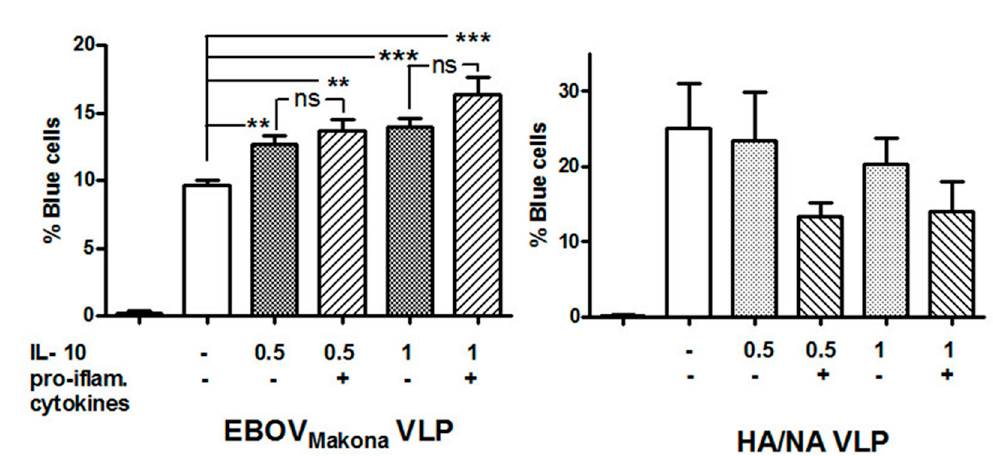
Figure 6. The enhancing e ff ect of IL-10 on EBOV VLP entry is preserved in the presence of pro-inflammatory cytokines. ( A ) MDM were pre-treated with IL-10, TNF- α or a combination of both for 48 h (IL-10 and TNF- α were used at a concentration of 20 ng / mL) and infected with EBOV Kikwit GP VLP. The first columns from the left represent mock infected cells. There was no di ff erence in the background fluorescence of mock-infected MDM incubated with cytokines or in medium alone. ( B ) MDM were pre-incubated with IL-10 (0.5 ng / mL or 1 ng / mL) or IL-10 plus a cocktail of pro-inflammatory cytokines (TNF- α , 0.1ng / mL; MIP-1 α , 0.1ng / mL; MIP-1 β and MCP-1, 2ng / mL; IL-8, 0.5ng / mL) for 48 h before infection. After the 3.5 h infection period, the cells were prepared for analysis by Laser Scanning Cytometry as described in Materials and Methods. * p ≤ 0.05; ** p ≤ 0.01; *** p ≤ 0.001; ns = not significant.